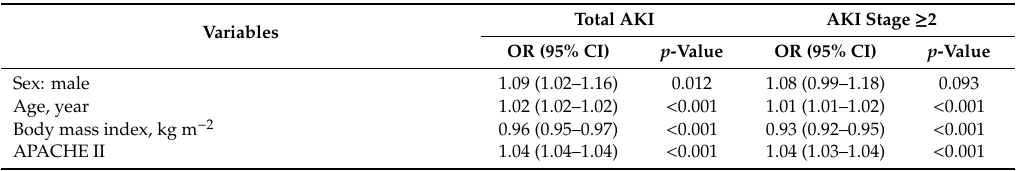
Table A2. Univariable logistic regression analysis of covariates for occurrence of total AKI and AKI stage ≥ 2 during 72 h after ICU